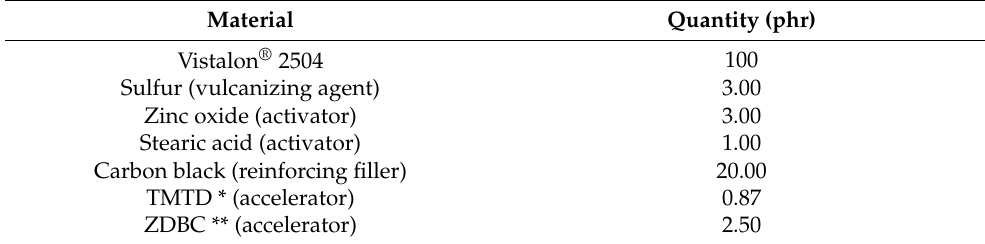
Table 1. Composition of the elastomeric compound used in this work. Material Quantity (phr) Vistalon ® 2504 100 Sulfur (vulcanizing agent) 3.00 Zinc oxide (activator) 3.00 Stearic acid (activator) 1.00 Carbon black (reinforcing filler) 20.00 TMTD *